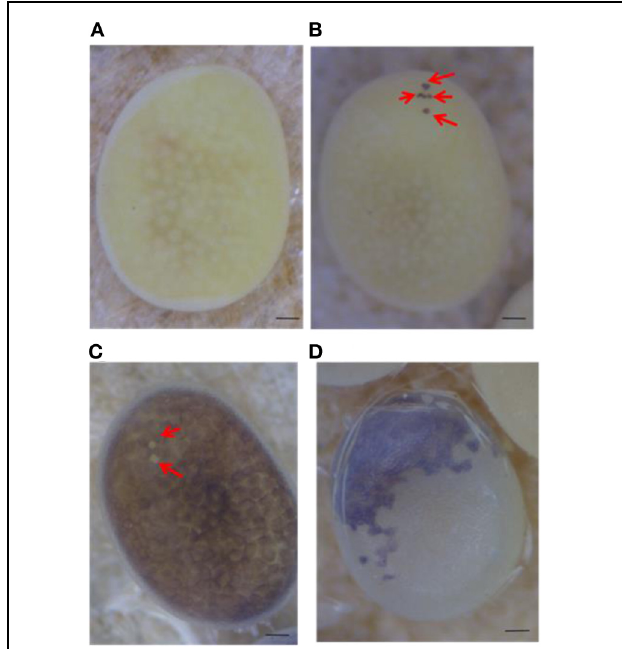
FIGURE 2 | Mosaic eggs observed in the present study. (A) White egg laid by a pe / pe female crossed with a pe / + pe male. (B) White egg with a small number of black serosal cells (red arrows) laid by a pe / + pe female crossed with a pe / pe male. (C) Black egg with a small number of transparent serosal cells (red arrows) obtained from a pe / pe female crossed with a pe / + pe male. (D) Half black and half white mosaic egg laid by a pe / pe female crossed with a pe / + pe male. Scale bars represent 100 µ